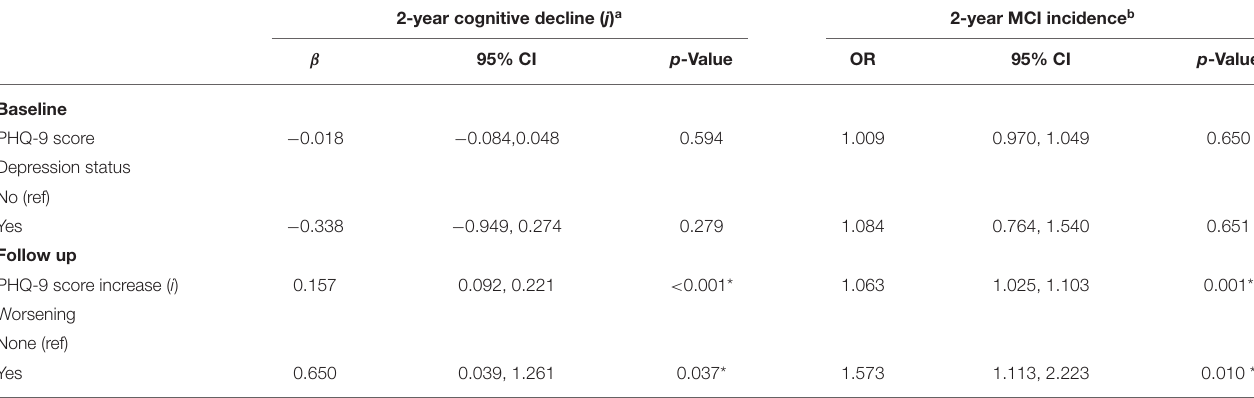
TABLE 2 | The associations between depression and cognitive function: Coefficients and 95% CIs for 2-year cognitive decline and Odds Ratios and 95% CIs for 2-year MCI